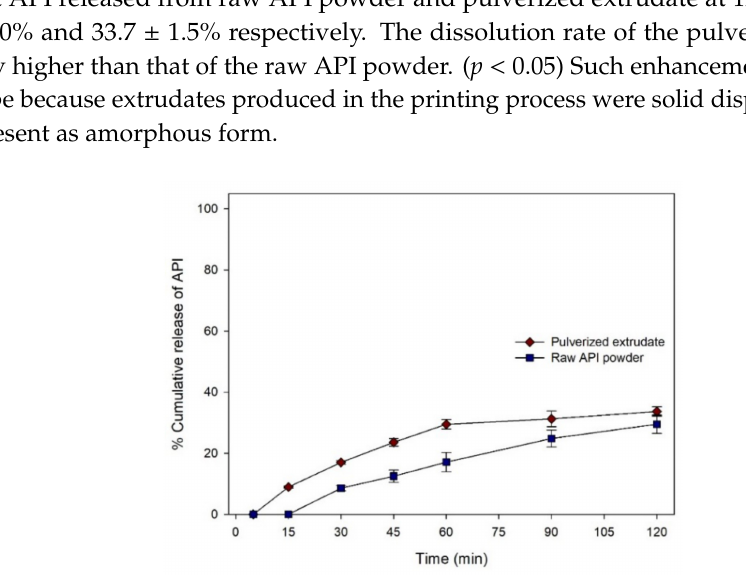
Figure 8. Dissolution rate of API powder and pulverized extrudate in pH 1.2 HCl